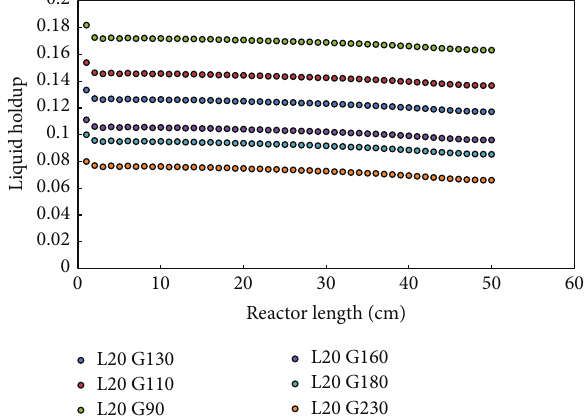
Figure 5: Calculated liquid holdups along the reactors for a liquid flow rates of 20 mLmin −1 and various gas flow